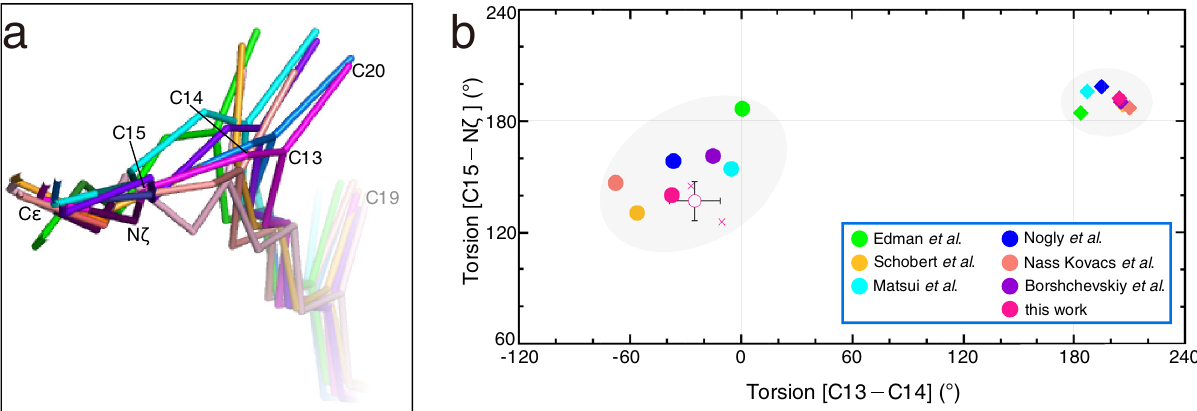
Fig. 5 Comparison with other K structures. a Superimposition of various K structures. Carbon atoms in 1QK0 reported by Edman et al. 13 , 1M0K by Schobert et al. 14 , 1IXF by Matsui et al. 15 , 6G7K by Nogly et al. 18 , and 6GA6 by Nass Kovacs et al. 19 , 7Z0C by Borshchevskiy et al. 16 and 7XJC reported in this work are colored in green, yellow, cyan, navy orange and magenta, respectively, while nitrogen (blue) atoms are in common. b Distribution of torsion angles of conjugated double bonds (C13 − C14 and C15 − N ς ) in retinal. The torsion angles for the K structures are plotted as fi lled circles in the same colors as used for the carbon atoms in panel a, while those for the corresponding ground state structures (1QKP 13 , 1M0L 14 , 1IW6 15 , 6G7H 18 , 6RMK 19 , 7Z09 16 and 7XJD) are plotted as fi lled diamonds. For the K and ground state structures in this study, the standard deviations calculated from three structures for each are shown as error bars on the mean values shown as hollow circles. Data points for respective structures in this study are shown as